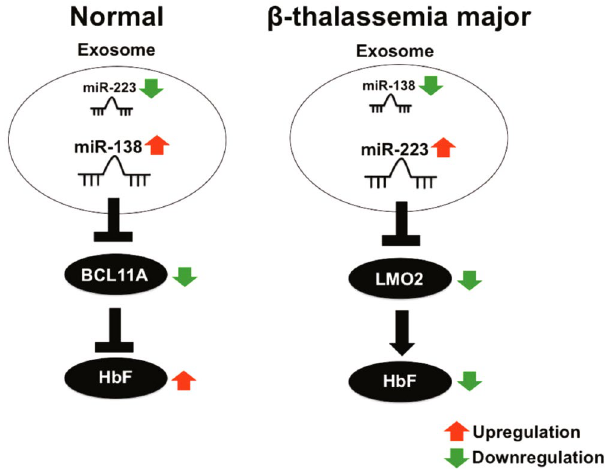
Figure 8. Exo-miRNA mediated γ -globin regulation. Reciprocally expressed exo-miRNAs (miR-223 and miR- 138) in the healthy donor and β -TM are involved in the γ -globin